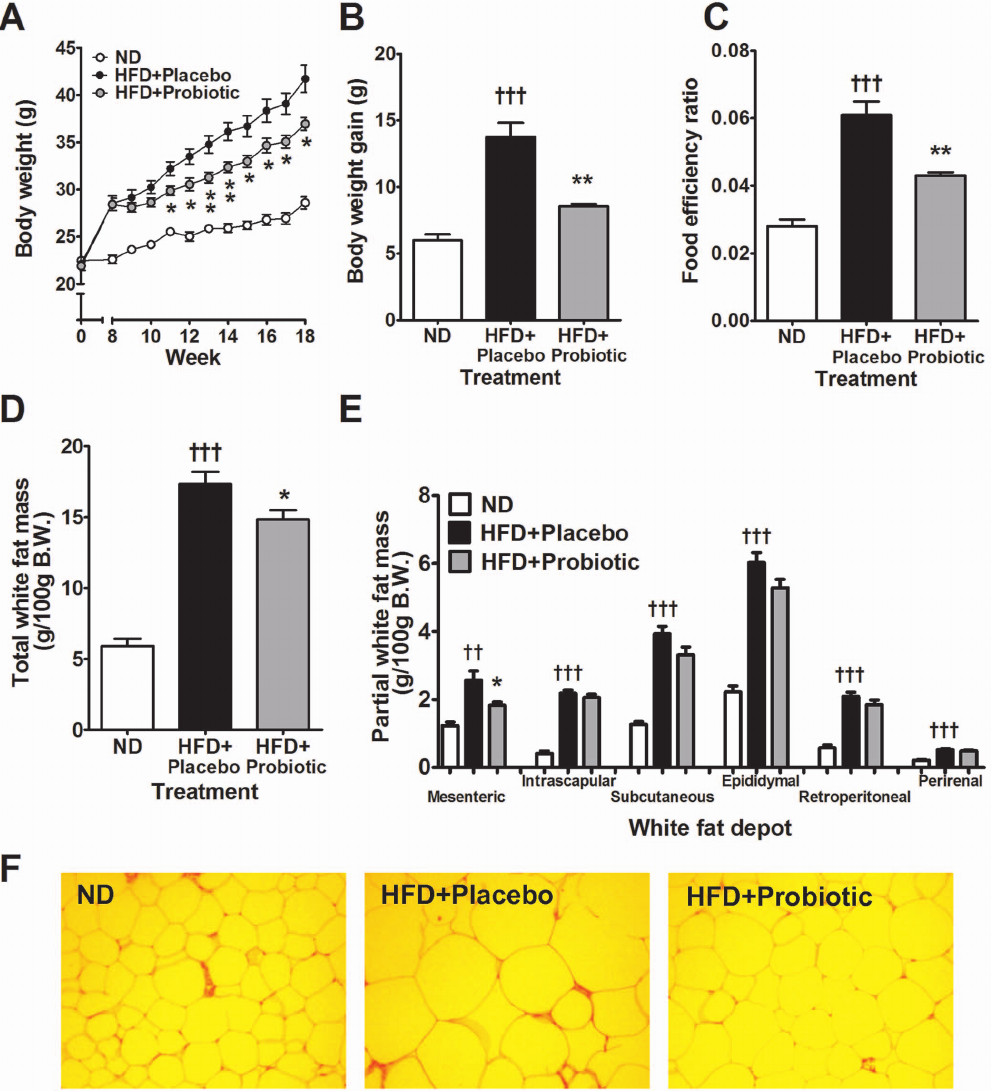
Figure 1. High-fat diet and probiotic effect on body weight, fat mass and adipocyte morphology. Effects of probiotic treatment on (A) body weight, (B) body weight gain, (C) food efficiency ratio, (D) total white fat mass, (E) partial white fat mass and (F) epididymal adipocyte morphology. Results are expressed as the means 6 SE. Significant differences HFD-placebo versus ND are indicated as {{ p , 0.01 {{{ p , 0.001. Significant differences between HFD-probiotic versus HFD-placebo are indicated as *p , 0.05, **p , 0.01. Epididymal adipose tissue morphology shown at 6 200 magnification.